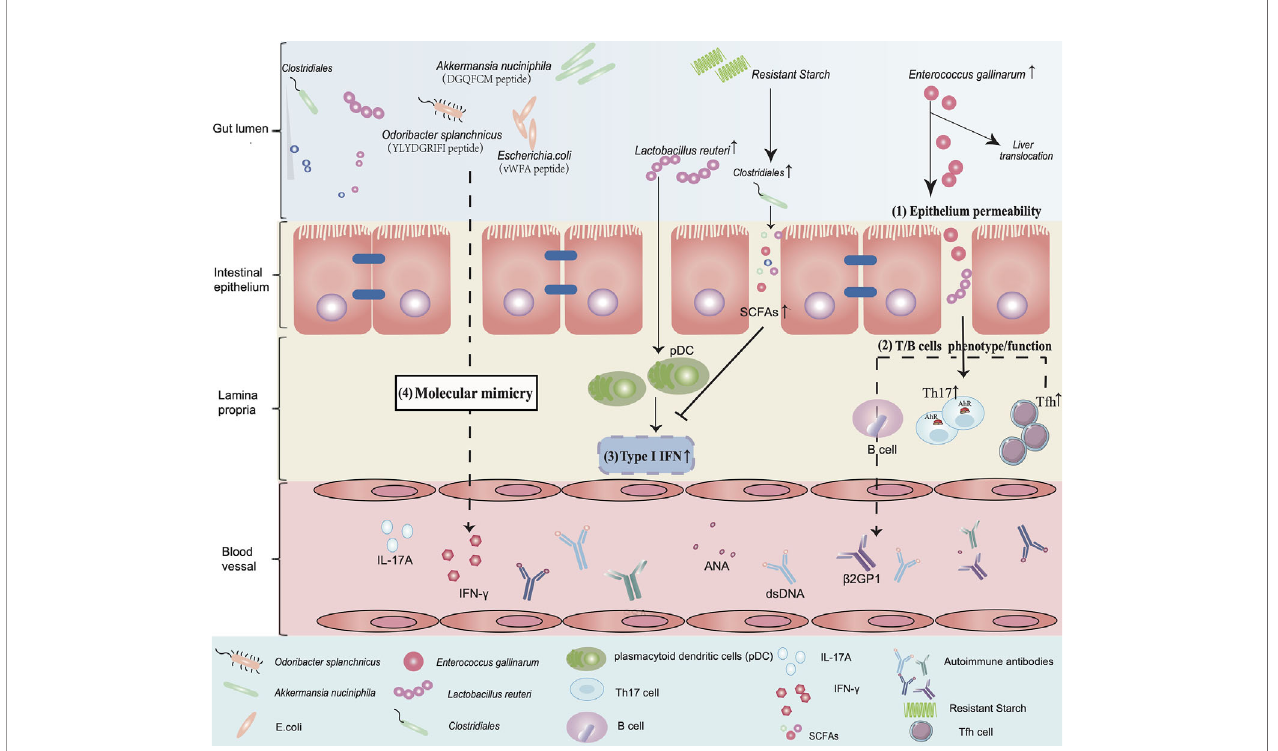
FIGURE 1 | An overview of the implication of gut microbiota in the aetiology of SLE. (1) Epithelium permeability: Enterococcus gallinarum induces an increase in epithelial permeability and translocates from the gut to the liver. (2) T/B cell phenotype/function: This triggers autoimmunity by upregulating the function of pDCs and Th17 cells and promotes the production of autoimmune antibodies such as dsDNA and b 2GP1 in systemic circulation. (3) Type I IFN: Lactobacillus reuteri enriched in a lupus model can worsen autoimmune manifestations by engaging in type I interferon pathways. Dietary resistant starch feeding of mice increases Clostridiales abundance and promotes SCFA production to suppress type I IFN production. (4) Molecular mimicry: The peptide “ YLYDGRIFI ” of Odoribacter splanchnicus signi fi cantly increases IFN- g and IL-17A expression in PBMCs of a subgroup of anti-Sm-positive SLE patients. The peptide “ DGQFCM ” from Akkermansia nuciniphila is capable of mimicking the extracellular part “ DGQFCH ” of human Fas and binds to IgG produced by memory B cells from SLE patients. Bacterial vWFA proteins expressed by E. coli can activate Ro60 reactive T